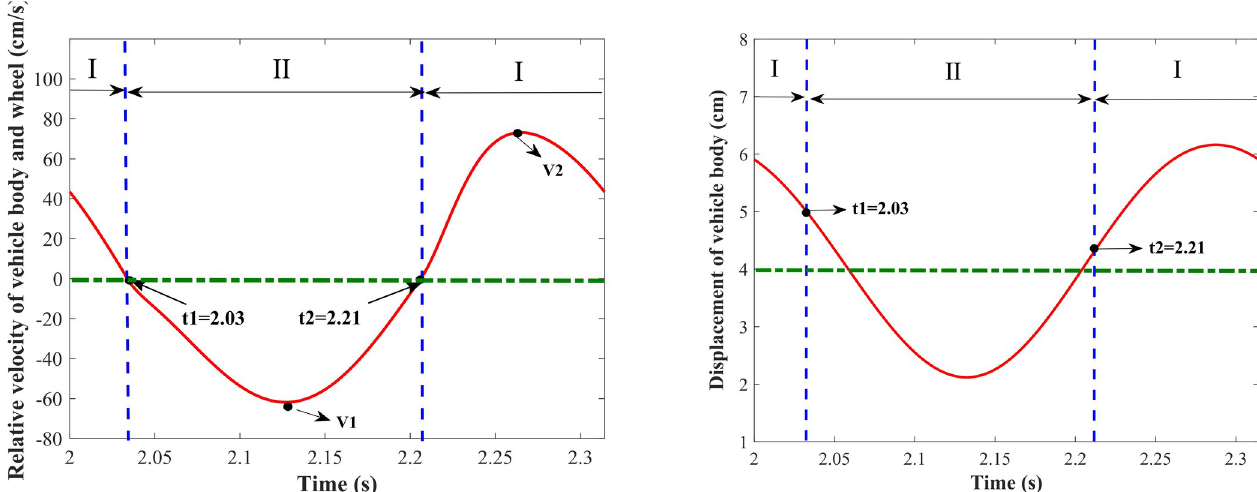
Fig 7. Curves of the relative velocity of vehicle body-wheel and vehicle body displacement in one cycle. (A) Relative velocity; (B) Displacement of the vehicle body.